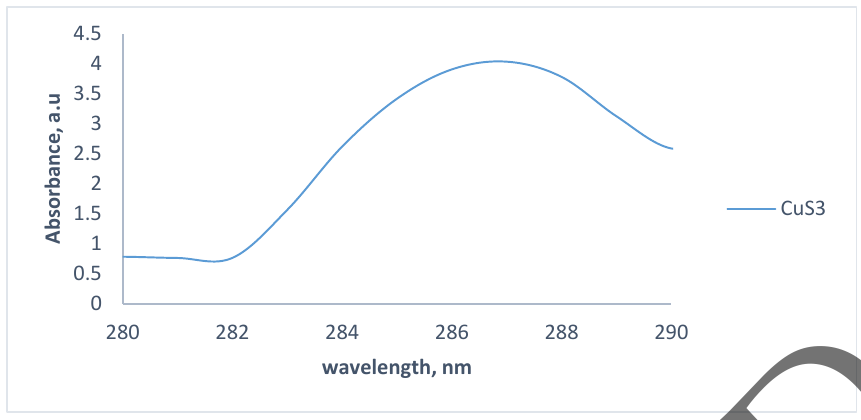
Figure 1. Absorption spectra of copper (II)- N -phenyl dithiocarbamate complex ( CuS1 ), copper (II)- N , N -ethylphenyldithiocarbamate ( CuS2 ), and copper (II)-morpholinedithiocarbamate ( CuS3 ) nanoparticles.